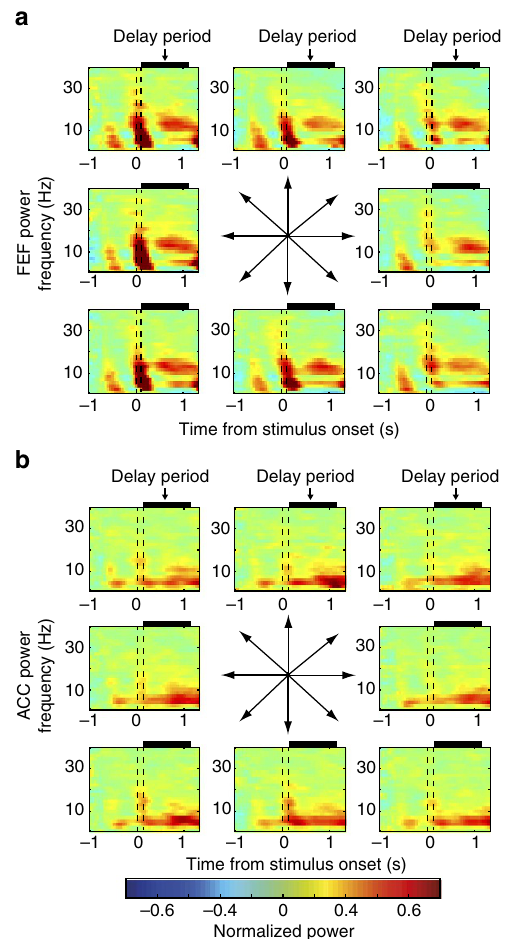
Figure 2 | LFP power in FEF and ACC during the memory-guided saccade task. ( a ) Average time-frequency spectra of the FEF LFP power across eight target locations in the memory-guided saccade task. ( b ) Average time frequency spectra of ACC LFP power across eight target locations in the memory-guided saccade task. The dashed lines demarcate the time of the onset and offset of the target stimulus. The black boxes on top of each graph demarcate the delay